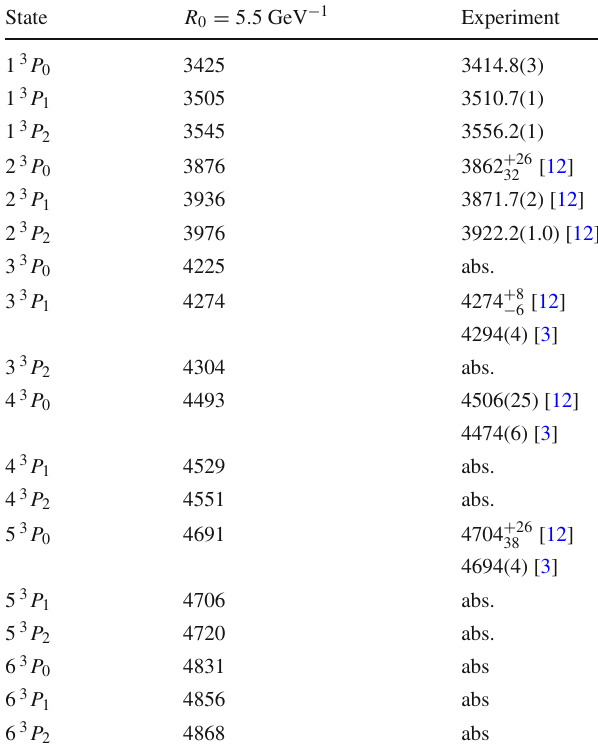
Table 8 The masses of the n 3 P J states (in MeV) in